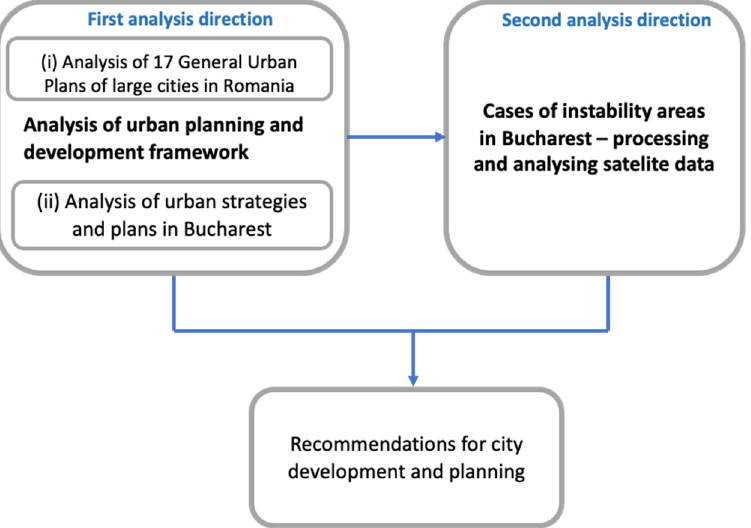
Figure 1. Research methodology for exploring the connection between urban development and urban subsurface hydrology. Source: elaborated by the